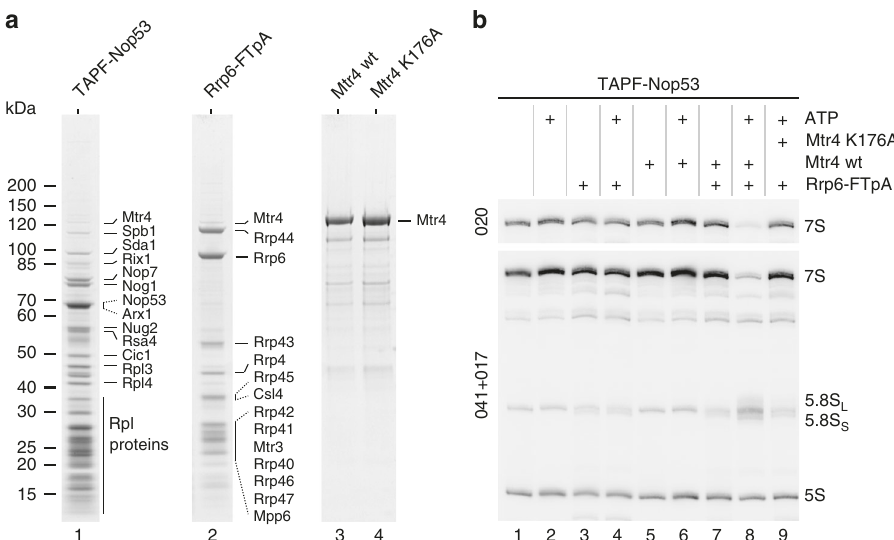
Fig. 1 In vitro assay for 7S → 5.8S pre-rRNA processing in puri fi ed pre-60S particles catalysed by the TAP-puri fi ed nuclear exosome and cofactors. a Analysis of the protein samples used for the in vitro 7S → 5.8S pre-rRNA-processing reaction. Substrate 7S pre-rRNA was part of the pre-60S particles af fi nity-puri fi ed via TAPF-Nop53. Endogenous yeast exosome was af fi nity-puri fi ed via Rrp6-FTpA, and recombinant yeast Mtr4, either wt or the K176A mutant, was expressed and af fi nity-puri fi ed from E. coli . The indicated eluates were analysed by SDS-PAGE and Coomassie staining. Marked bands of the exosome were identi fi ed by mass spectrometry. b Northern blot for the detection of 7S pre-rRNA, 5.8S rRNA and 5S rRNA species after the in vitro processing reaction. Processing of 7S pre-rRNA from pre-60S particles (TAPF-Nop53) using the endogenous yeast-derived nuclear exosome (FTpA-Rrp6) and its cofactor Mtr4, either wt or K176A mutant, in the presence or absence of ATP. 7S pre-rRNA was detected with two different probes. 5S rRNA